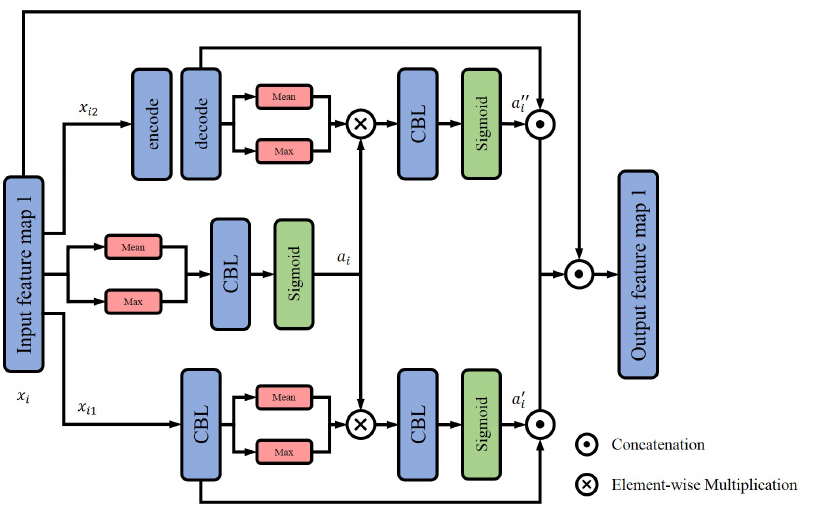
Figure 1. Structure of SAS